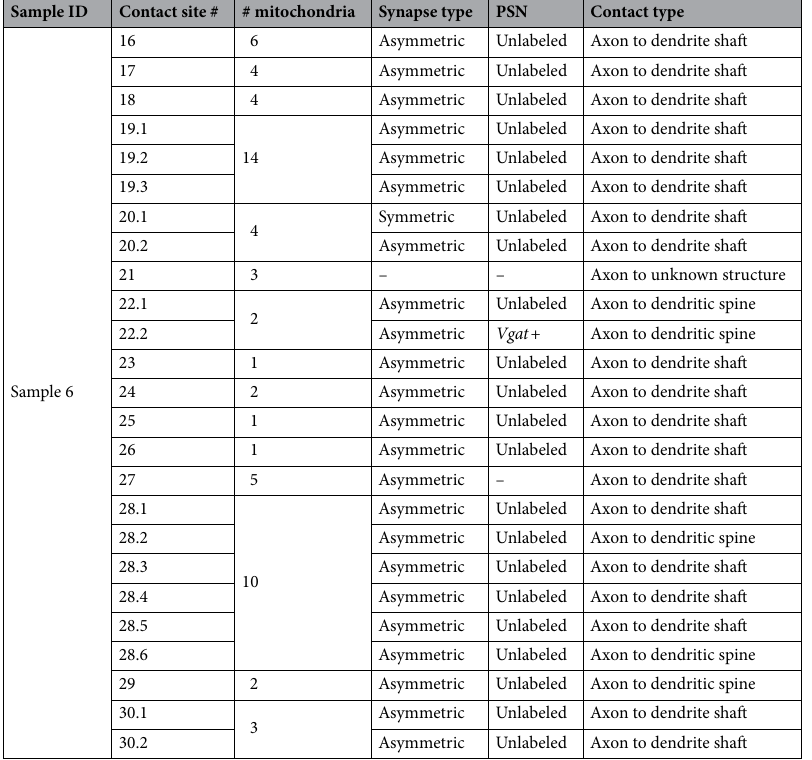
Table 1. Summary of examined ACC axons in FIBSEM samples (see Fig. S4 for list of